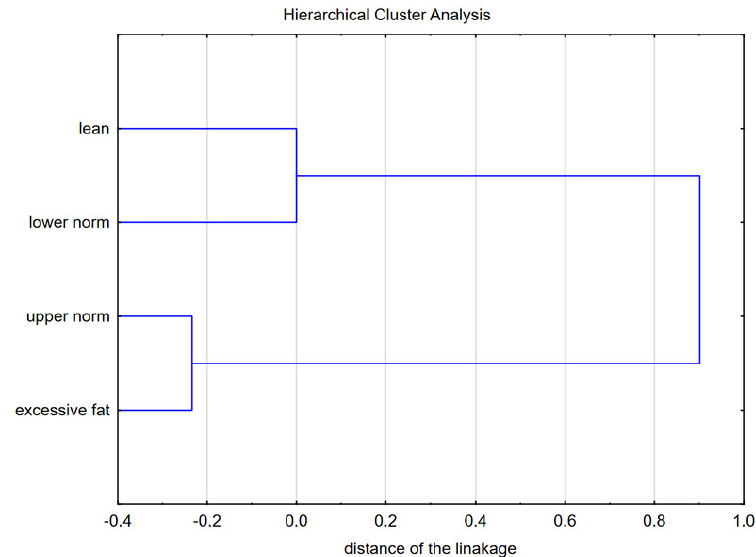
Figure 5. Cluster analysis of the groups of lean, lower normal, upper normal, and excessive fat participants based on the best-discriminating subset of variables (active transport, leisure time, walking intensity, and healthy dietary behaviors).